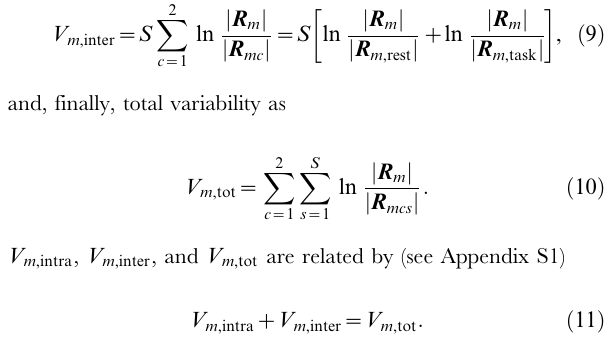
Table 2. Pairwise effects of method on signal variance.